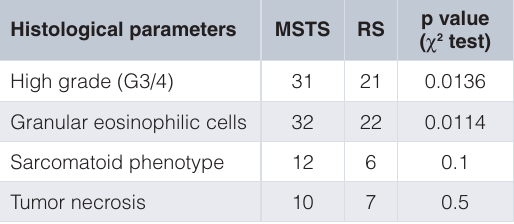
F1000Research: Dataset 1. Clinic-pathological data correspond- ing to the two RS and MSTS sampling methods in 38 CCRCC,